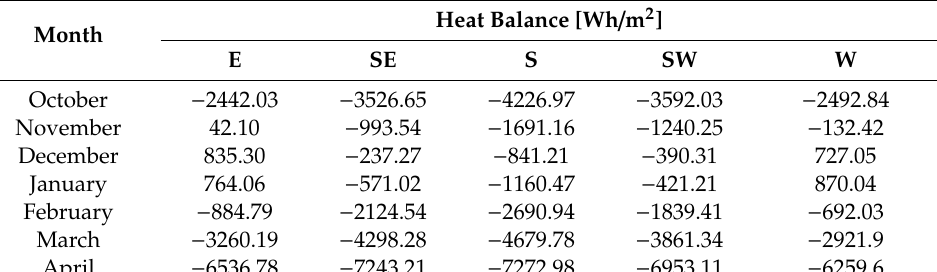
Table 6. Heat balance calculated for the months of the heating season depending on the orientation with respect to cardinal points.